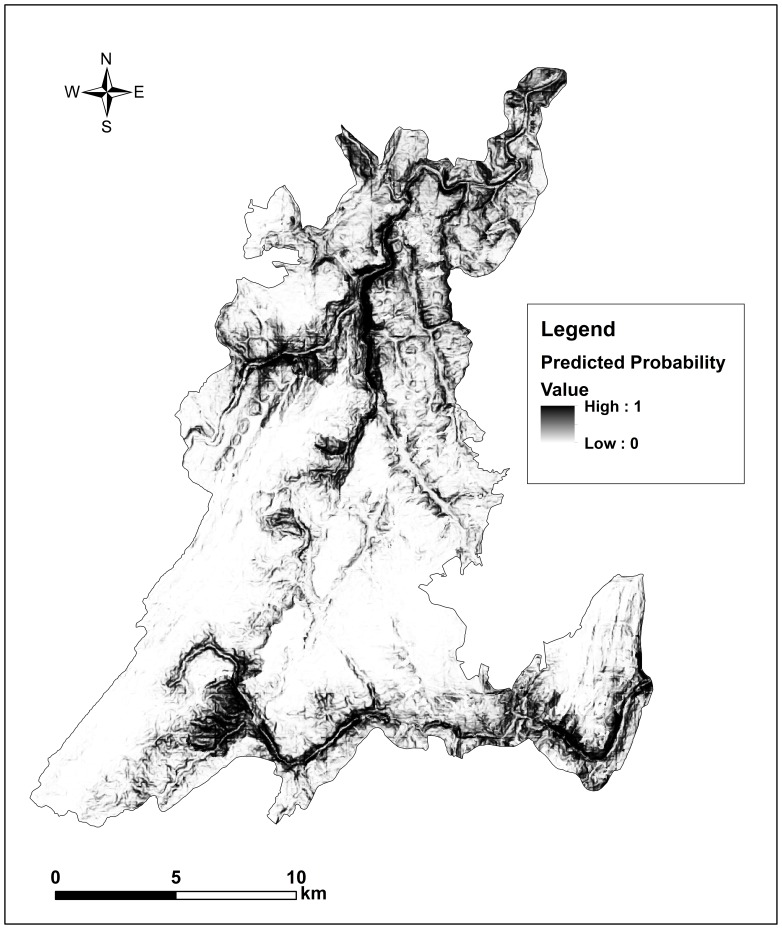
Habitat suitability of Francois’ langur in Mayanghe National Nature Reserve, China based on the use probability predicted by the logistical regression model (
Table 3
).The darker the color, the higher the habitat suitability.